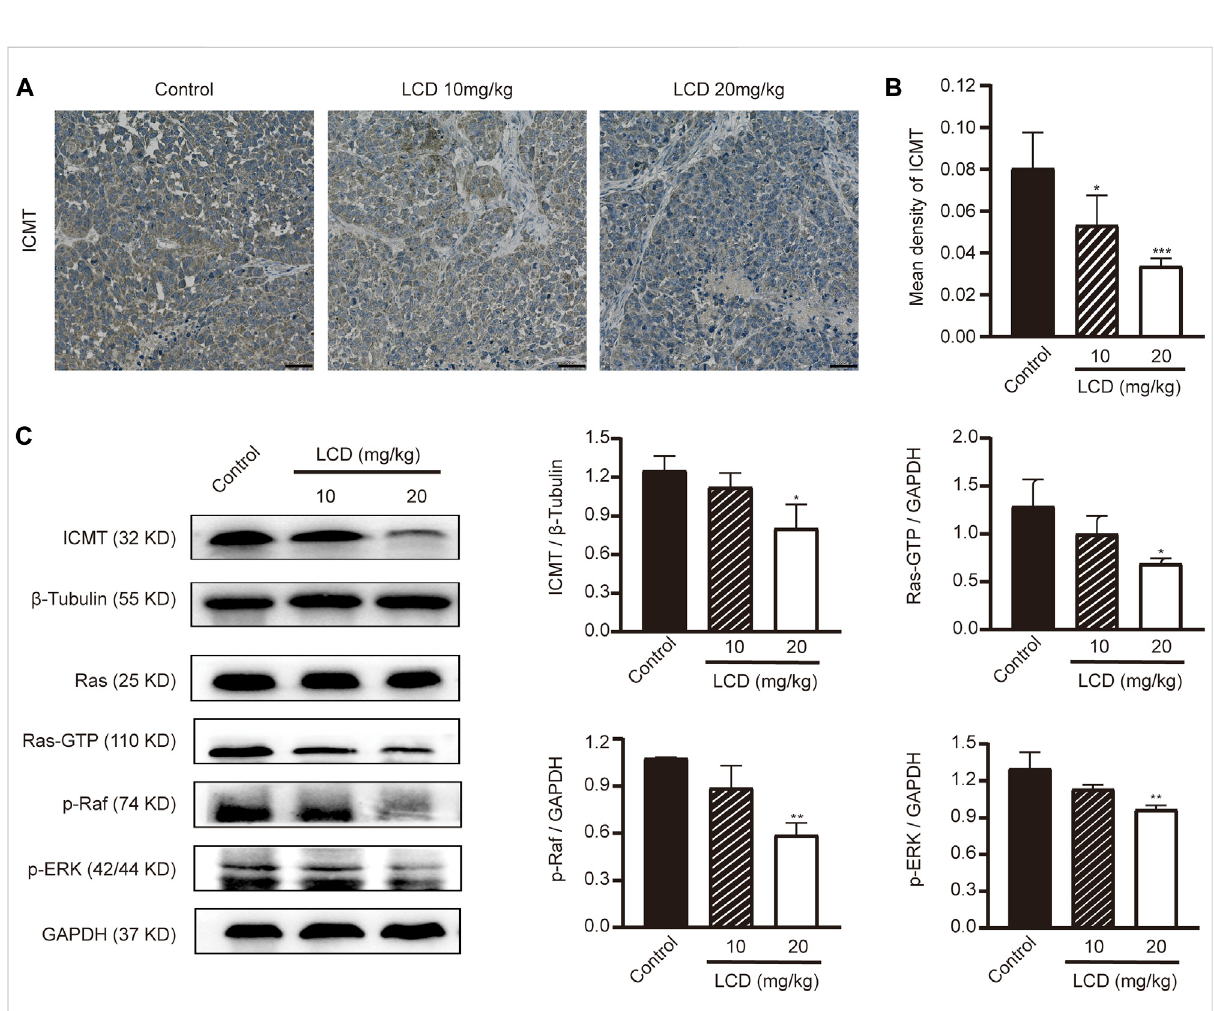
FIGURE 7 Licoricidin blocked the ICMT/Ras signaling pathway in vivo . (A) Immunohistochemical staining images of ICMT in xenografted tumors treated withdifferentconcentrationsoflicoricidin. (B) MeandensitiesofpositivelyexpressedICMTproteinwerecalculatedfrom fi verandom fi eldsofviewby Image-Pro Plus 6.0 software for quantitative analysis. (C) Expressionlevels of proteins (ICMT,Ras-GTP,p-Raf, andp-Erk)taking part intheICMT/Ras signaling pathway in xenografted tumors were assessed by Western blot analysis and normalized by reference genes for quantitative analysis. Results are displayed as mean ± SD of three independent experiments. * p < 0.05, ** p < 0.01, and *** p < 0.001. LCD, licoricidin. 5-FU, 5- fl uorouracil. Scale bar, 50 μ